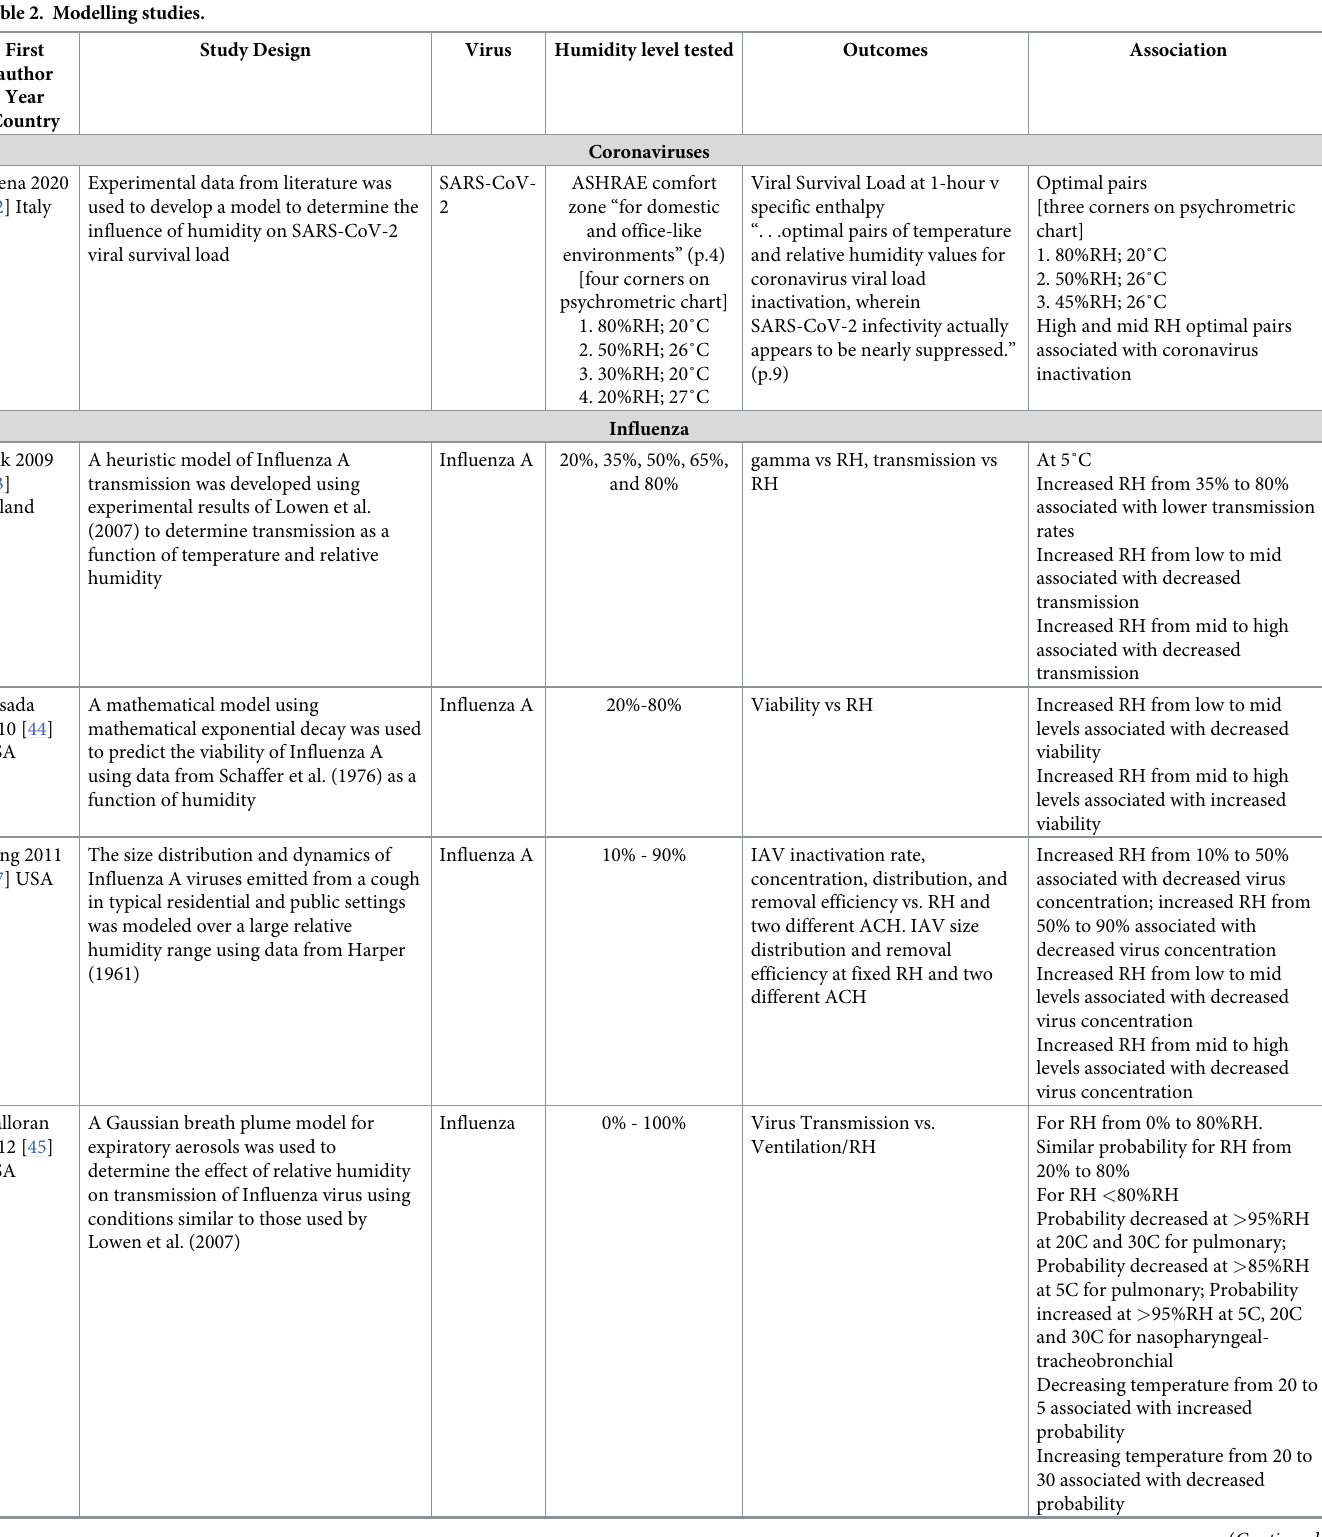
Table 2. Modelling